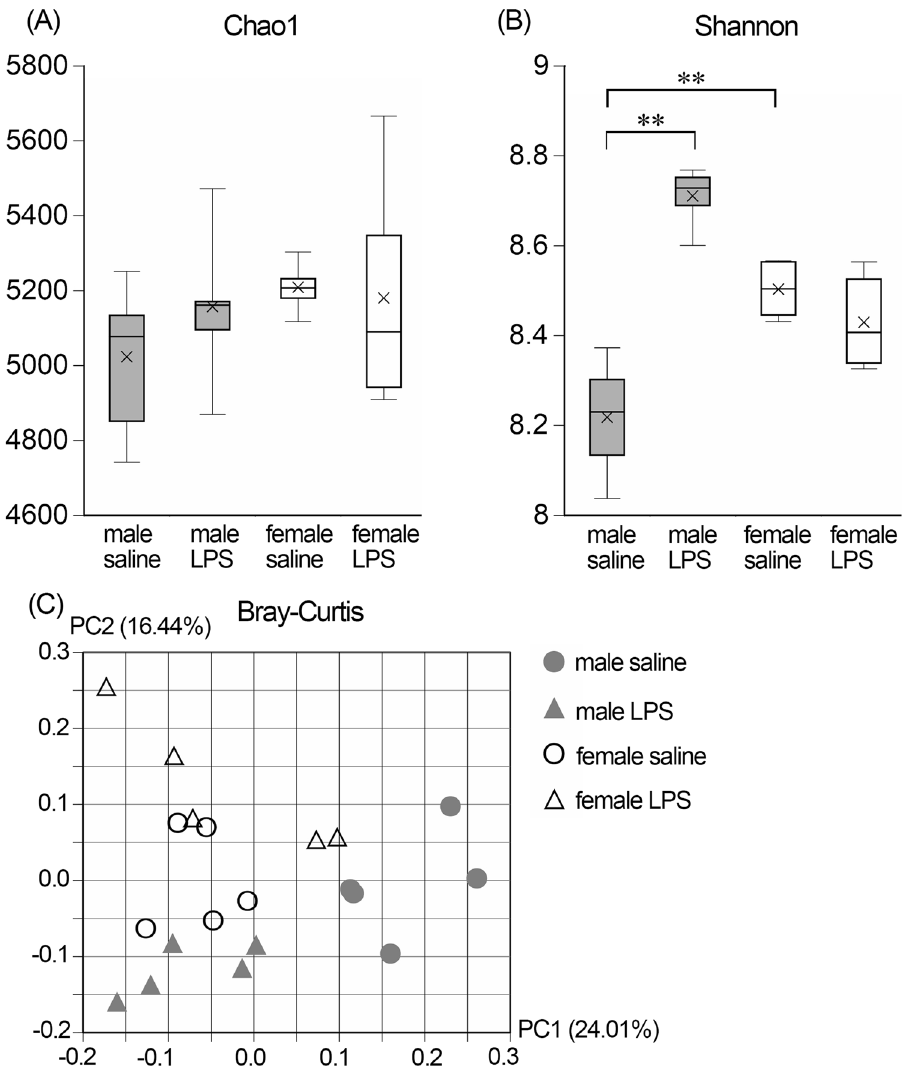
Figure 1. Diversity of gut microbiota. ( A ) Chao1 index. ( B ) Shannon index. The middle line in the box plot represents the median value, and the box is drawn indicating the 25 to 75% quartiles. Whiskers show minimum and maximum values and the ends of the whiskers represent the non-outlier range. Mean values are shown as ×. Data were analyzed with a 2-way ANOVA (sex × treatment) with Tukey’s HSD post hoc test. ** p < 0.01. ( C ) Principle component analysis (PCA) based on Bray–Curtis dissimilarities among all sample sets. Dots with different symbols indicate samples collected from different groups. PC1: first principal coordinate, percent variation 24.01%; PC2: second principal coordinate, percent variation 16.44%. n = 5 for each